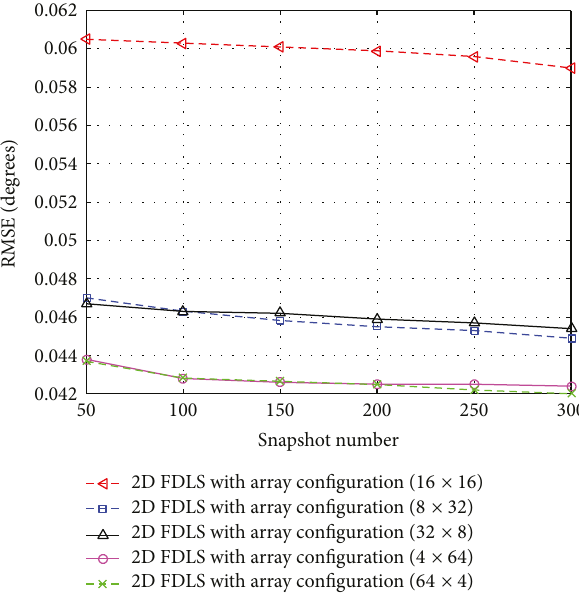
Figure 7: RMSE for massive MIMO DOA estimation versus source number for SNR=10 dB with di ff erent types of array con fi guration.